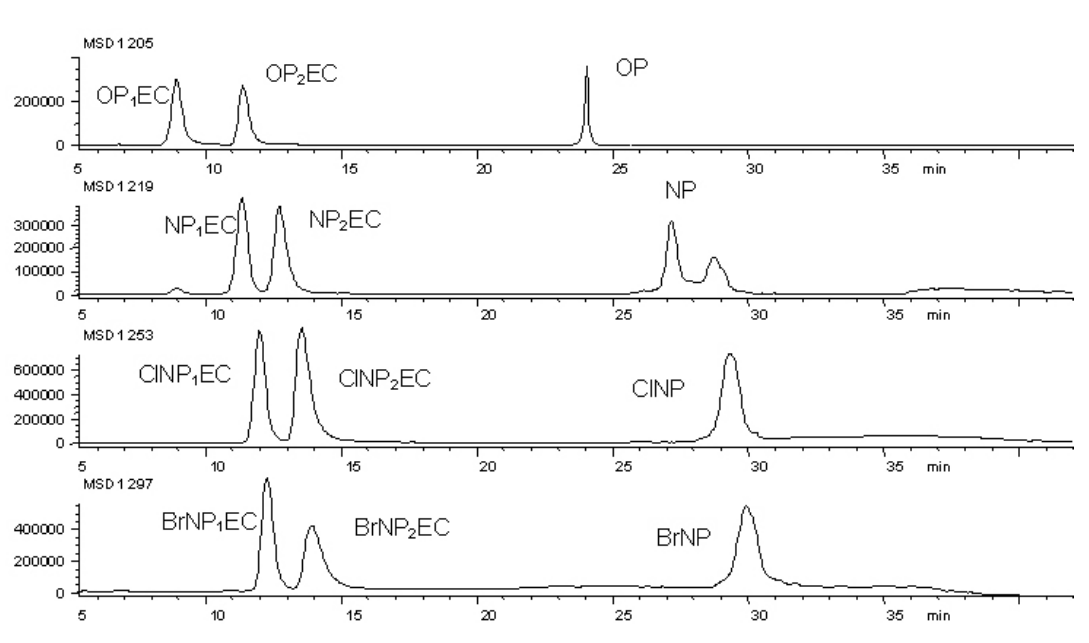
FIGURE 2. RAM–LC–MS extracted chromatograms for alkylphenolic compounds detected under NI